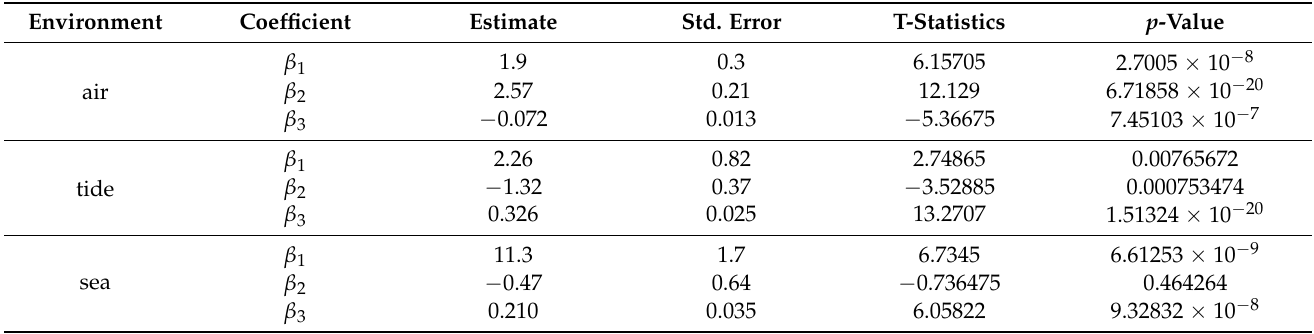
Table 5. The regression parameters of the three formed models for NiTi2 corrosion depth in the air, tides, and